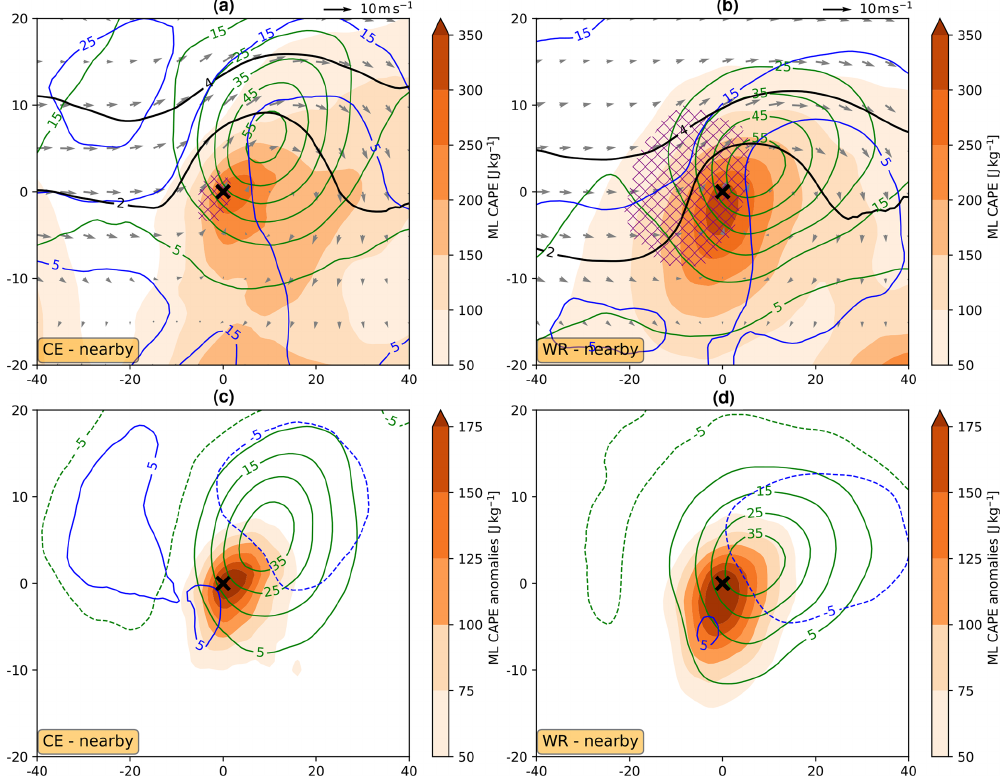
Figure 9. Same as Fig. 8 but for the nearby heating branch reaching central Europe (a, c) and western Russia (b, d) . Note that WCB frequencies are not shown because they are negligible in the nearby branch. The top row shows the full fields and the bottom row the anomalies. The purple hatching marks, in contrast to Fig. 8, the area where the convective precipitation exceeds the stratiform precipitation (only for areas with total precipitation ≥ 2mmd − 1